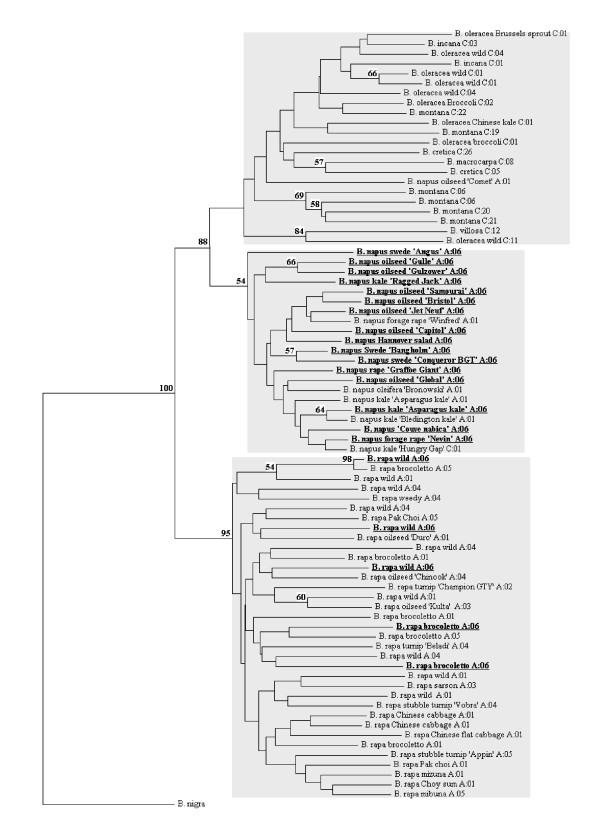
NJ tree of AFLP data. Chloroplast halptypes of each accession are indicated. Accessions with the A:06 (common B. napus) chloroplast haplotype are shown in bold and underlined. Numbers at nodes indicate % bootstrap support (out of 100 bootstrap replicates).